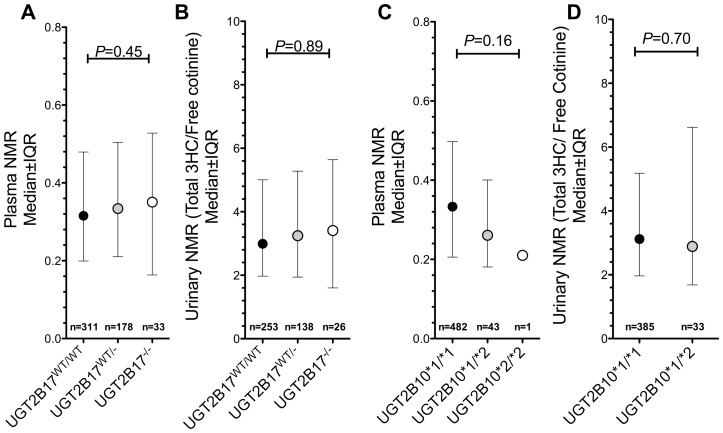
The association between UGT2B17 gene deletion and UGT2B10*2 with NMR.
UGT2B17 gene deletion was not associated with plasma (A) or urinary NMR (B). UGT2B10*2 genotype was not associated with plasma (C) or urinary NMR (D). Urinary samples were only available for 426 individuals. IQR = Interquartile range. No significant difference in plasma NMR between UGT2B10 genotype groups was found when the UGT2B10*1/*2 and *2/*2 groups were pooled. Similar findings were observed after statistically adjusting for gender, age and body mass index.